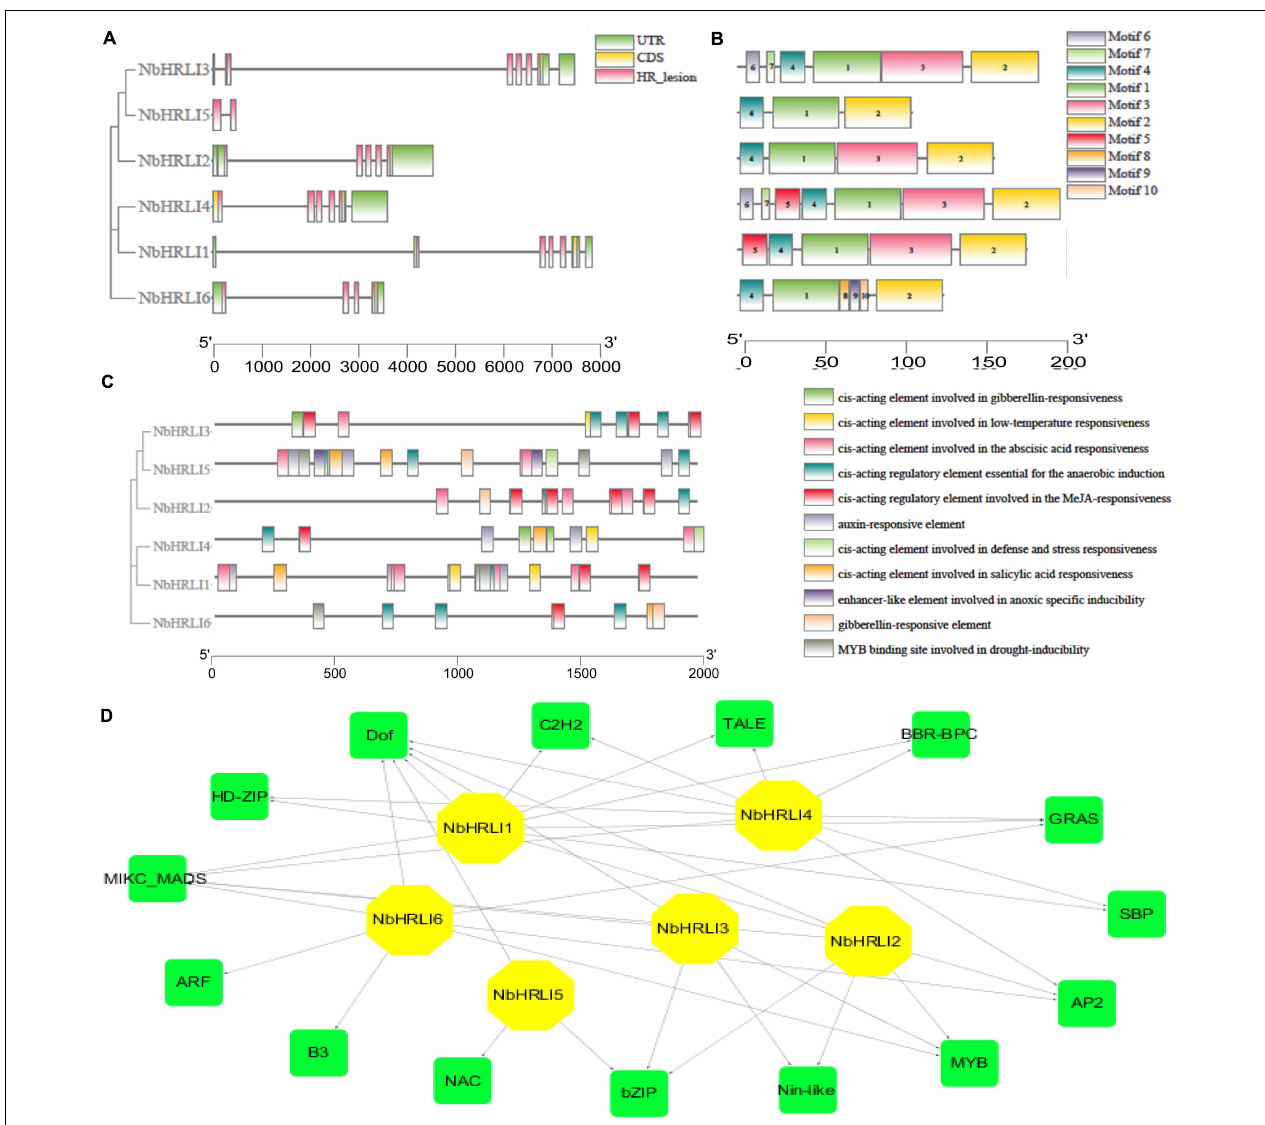
FIGURE 1 | Genome-wide identification and bioinformatic analysis of NbHRLIs. (A) Phylogenetic tree of protein sequences and exon-intron structure of NbHRLIs. The HR_lesion domains are shown by pink boxes. Green boxes represent untranslated 5 (cid:48) - and 3 (cid:48) -regions; yellow boxes are exons; black lines represent introns. (B) The motif composition of NbHRLIs. The motifs are displayed in different colored boxes. (C) Position, quantity, and kind of environmental stress-related and hormone-responsive cis -acting elements in NbHRLIs. (D) Regulation network between NbHRLIs and potential TFs. Green rectangles represent TFs, yellow hexagons represent NbHRLIs, and black lines indicate potential regulatory